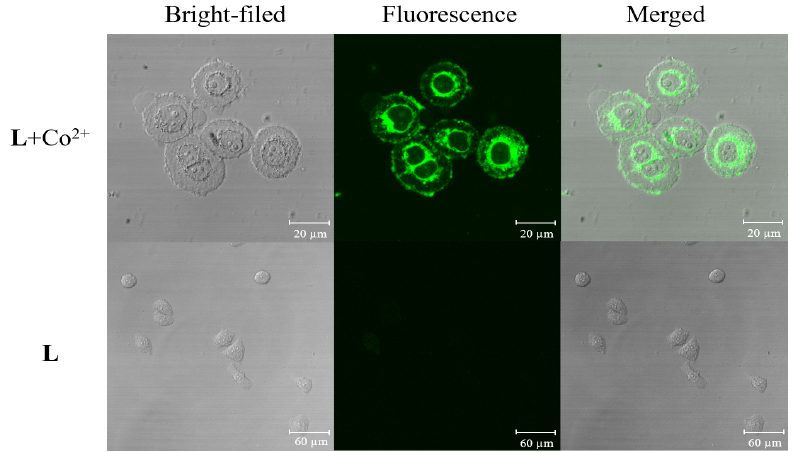
Figure 11. Fluorescence images of HepG2 cells treated with the L probe and Co 2+ . Bright-field image (left); fluorescence image ( λ ex = 380 nm) (middle); and merged image of bright-field and fluorescence image (right).